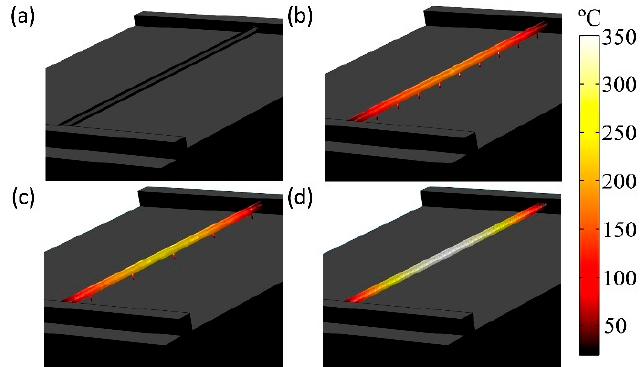
Figure 5. 3D model of the simulated temperature profile along a nanowire with d = 60 nm, σ = 100 S·m − 1 and κ = 1 W·m − 1 ·K − 1 in four different scenarios: ( a ) full flat contact with the substrate; ( b ) with 10 contact points; ( c ) with 5 contact points; and ( d ) fully suspended. A power of 3.7 μ W was applied in all cases. Reproduced from Ref. [40], with permission from